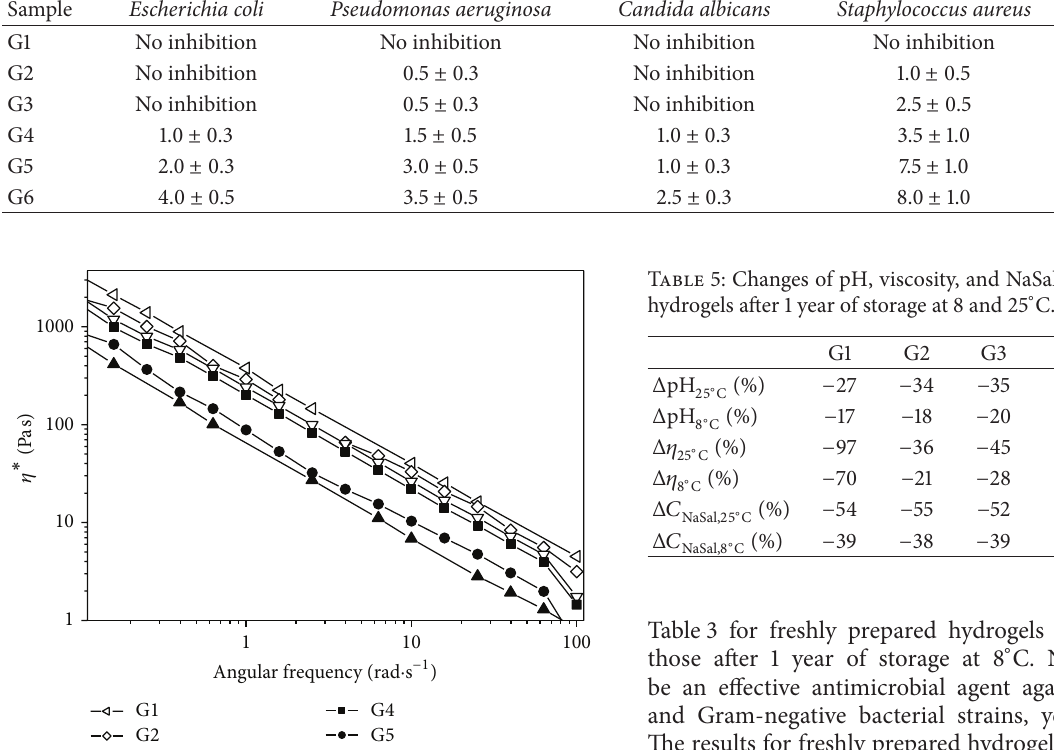
Table 4: Antimicrobial activity of samples G1–G6 after 1 year of storage at 8 ∘ C expressed as inhibition zone diameter (mm). Sample